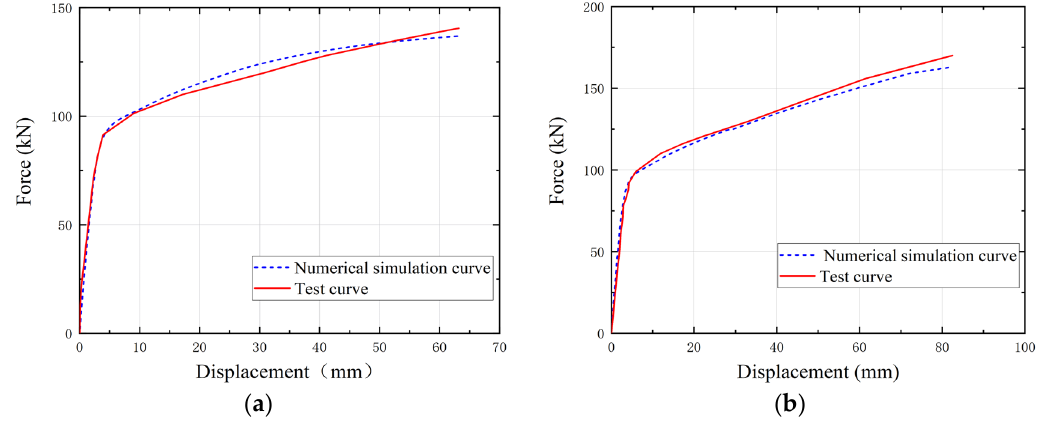
Figure 13. Comparison of the test curve and the numerical simulation curve. ( a ) Specimen D16, ( b ) Specimen M20.